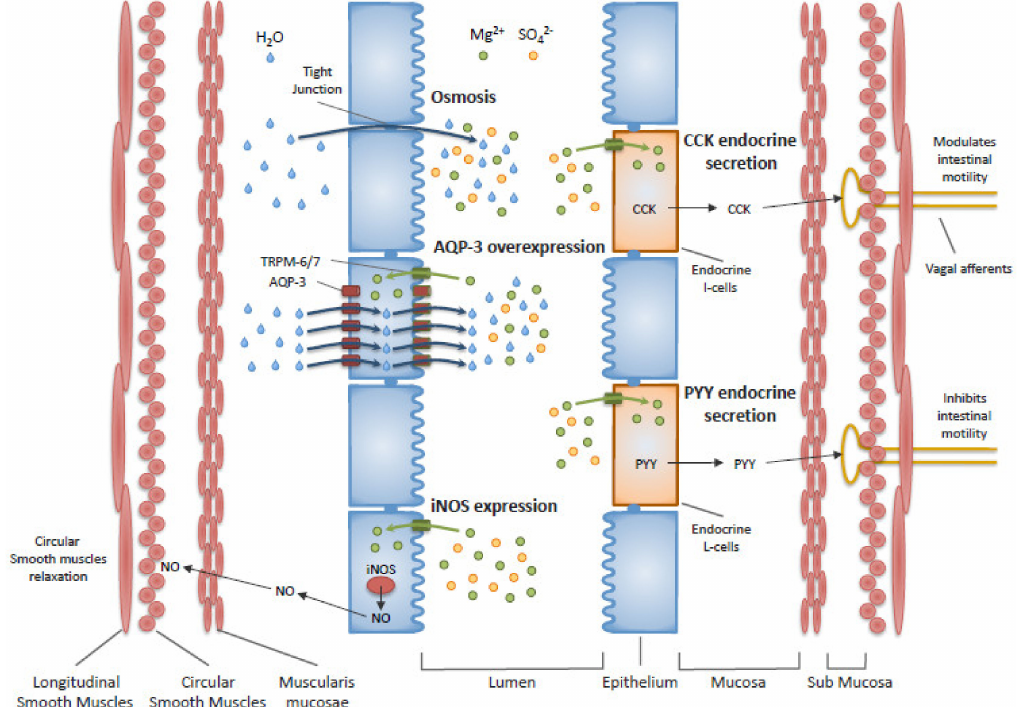
Figure 1. Schematic representation of the five mechanisms of action currently proposed for magnesium sulfate in functional constipation: Osmosis, AQP-3 overexpression, iNOS expression, CCK endocrine secretion and PYY endocrine